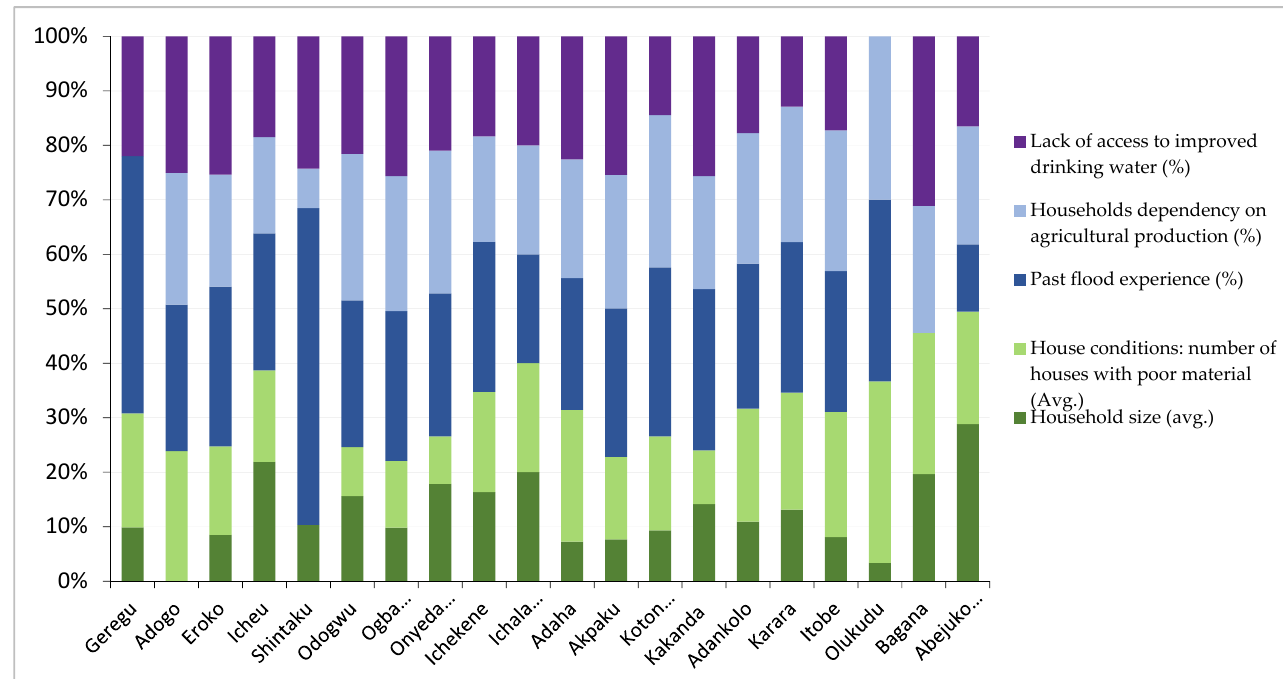
Figure 7. Contribution of the single indicator to the sub-index susceptibility ( SIS ) for the different selected flood-prone communities in Kogi State.